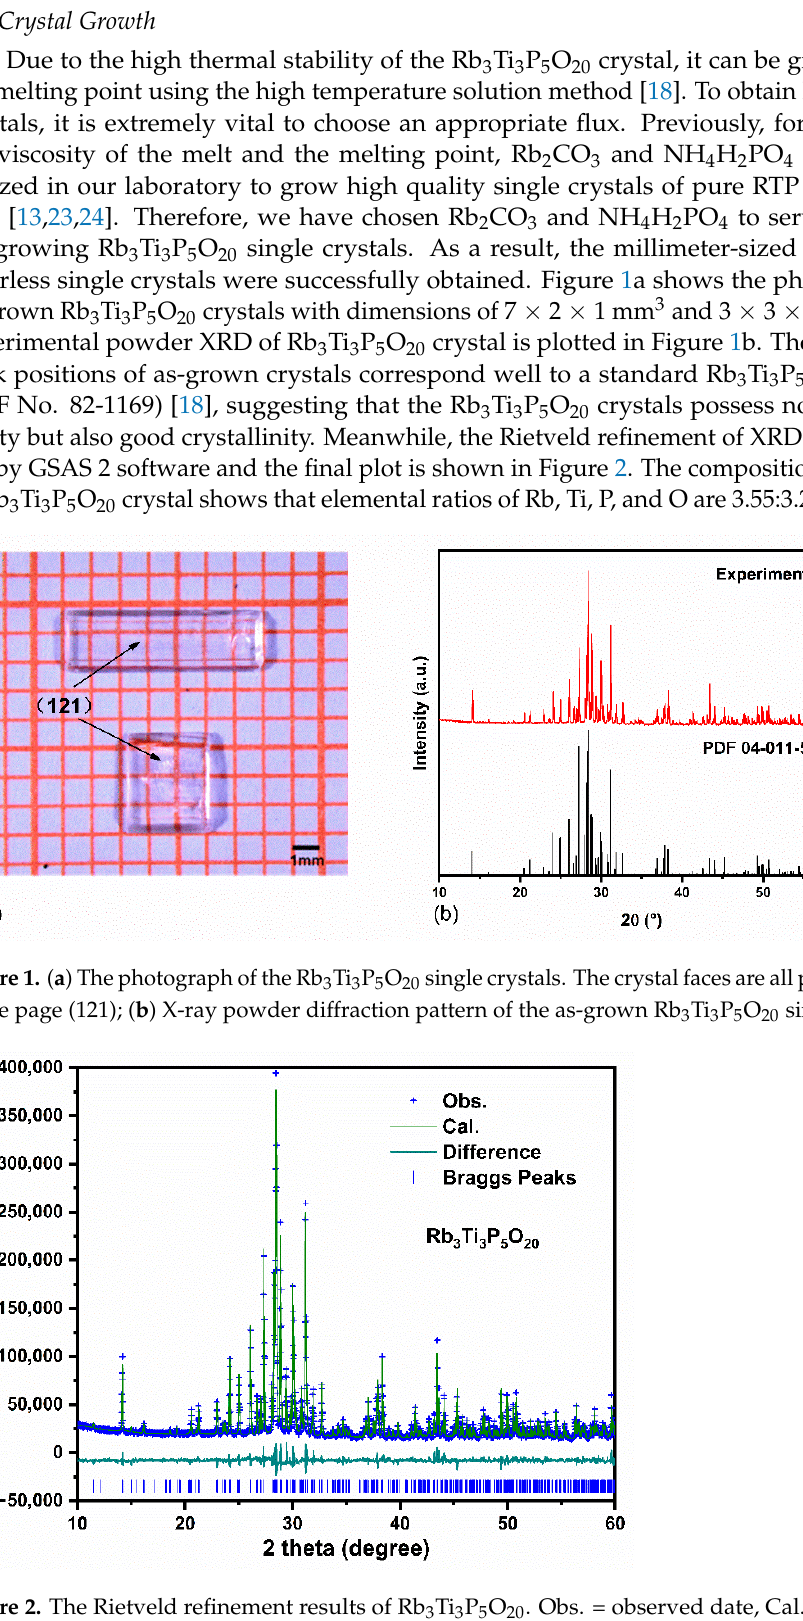
Figure 2. The Rietveld refinement results of Rb 3 Ti 3 P 5 O 20 . Obs. = observed date, Cal. = calculated date, Difference = Obs. − Cal., Braggs Peaks represent the diffractions peak